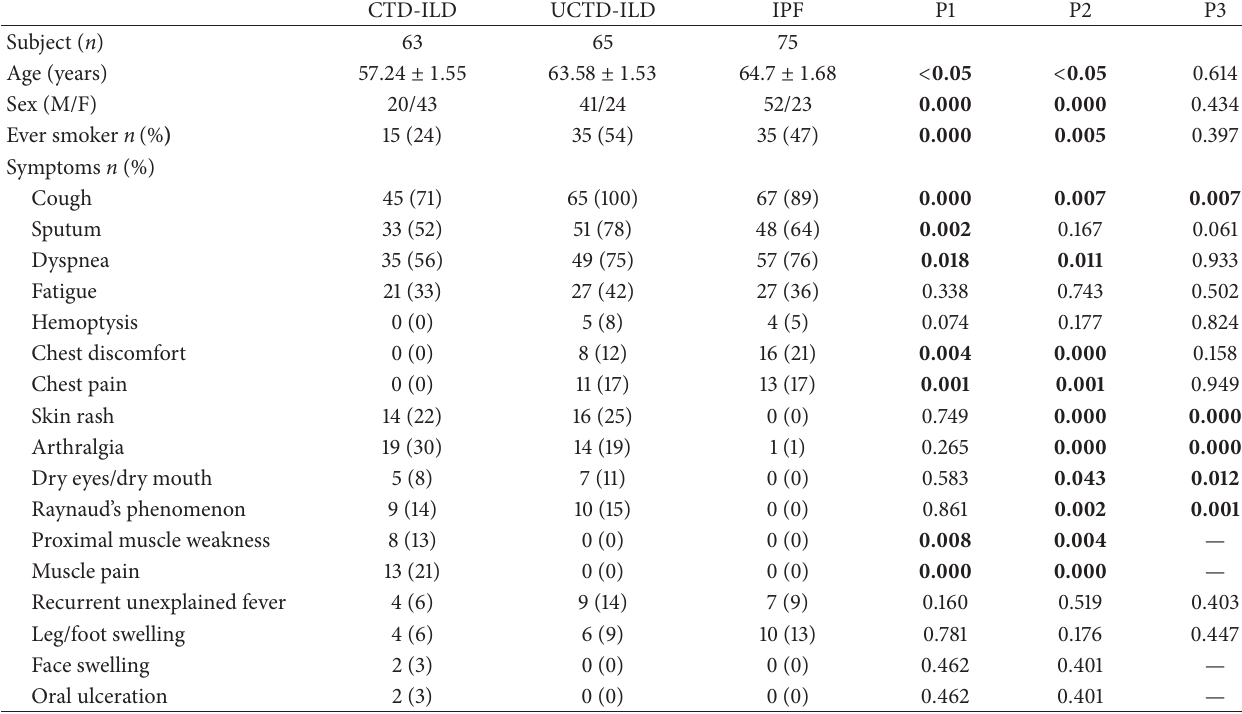
Table 2: Comparison of clinical characteristics among CTD-ILD, UCTD-ILD, and IPF patients.